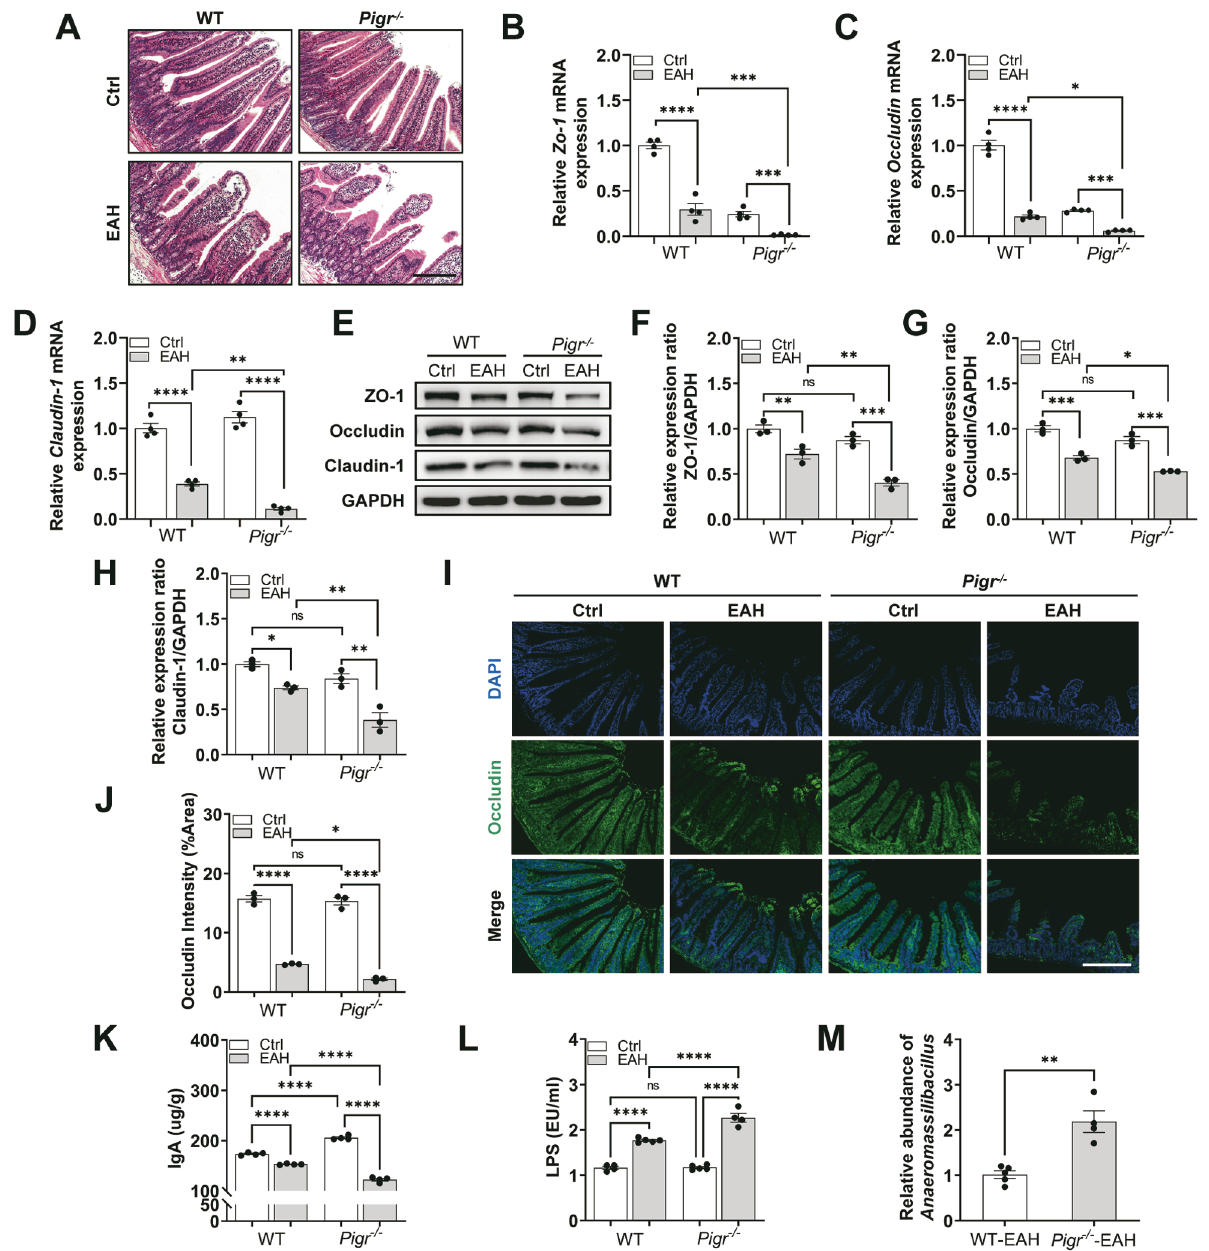
staining and quanti fi cation of Occludin. Scale bar = 200 μ m. K Immunoglobulin A (IgA) levels. L Liver lipopolysaccharides (LPSs) level. M The abundance of the Anaeromassilibacillus genus between WT-EAH and Pigr − / − -EAH was validated by quantitative PCR. Data are presented as mean ± SEM. Statistical analysis was performed using one-way ANOVA with Tukey multiple